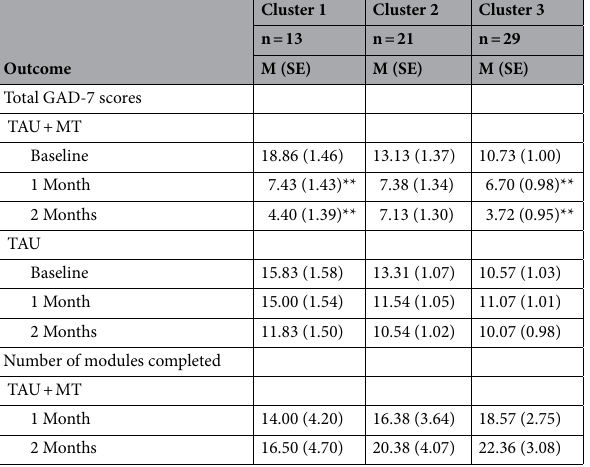
Table 2. Anxiety (GAD-7 scores) and engagement (number of modules completed) by treatment group and cluster at each assessment timepoint. TAU + MT = treatment as usual + mindfulness training; TAU: treatment as usual; GAD-7: generalized anxiety disorder-7 item scale. ** p < 0.001, follow-up contrasts from mixed measures